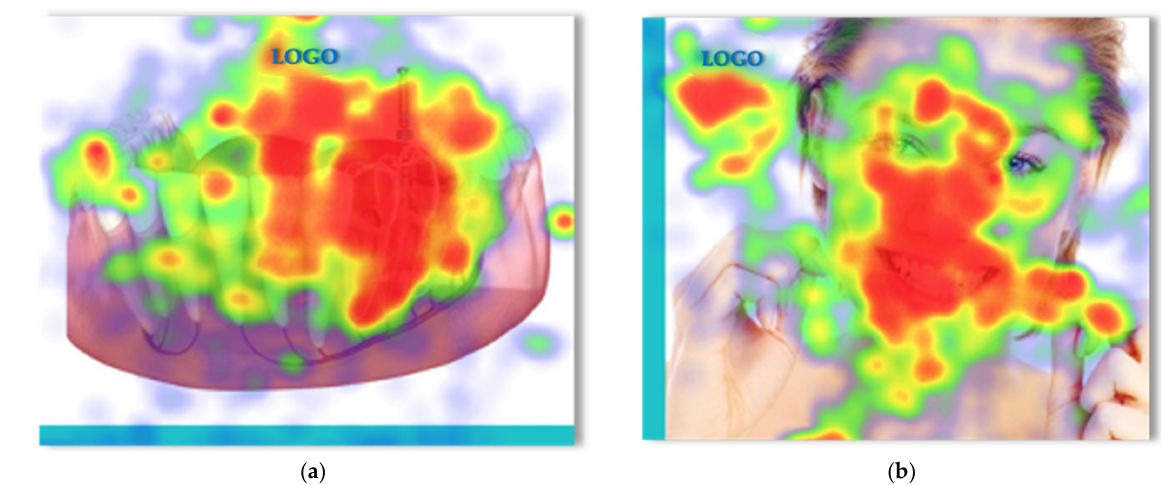
image: in Image A, area 1—the professional utensil, and area 2—the logo; and in Image B,